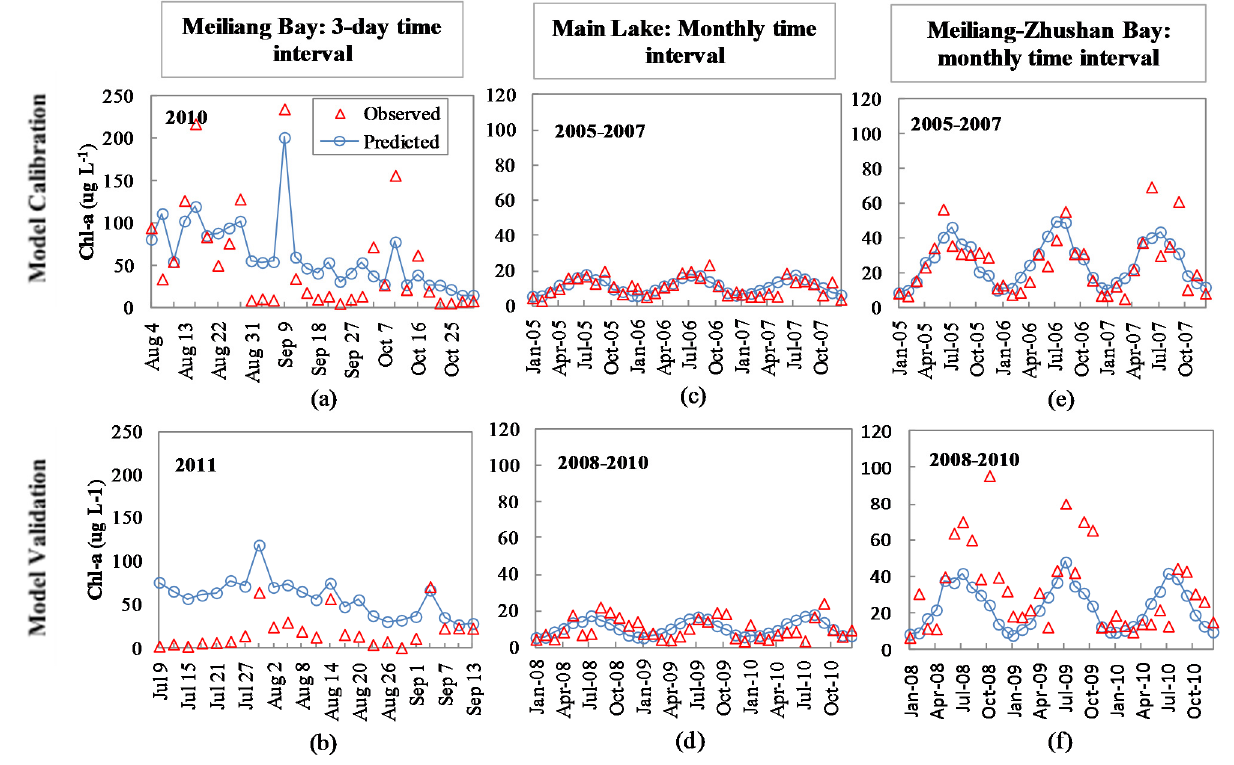
Figure 3. Observed and predicted Chlorophyll a (Chl-a) concentrations for: ( a , b ) Meiliang Bay, three-day measurement intervals; ( c , d ) main lake, monthly measurement intervals; and ( e , f ) Meiliang-Zhushan Bay, monthly measurement intervals. The independent variables here are total nitrogen (TN) and